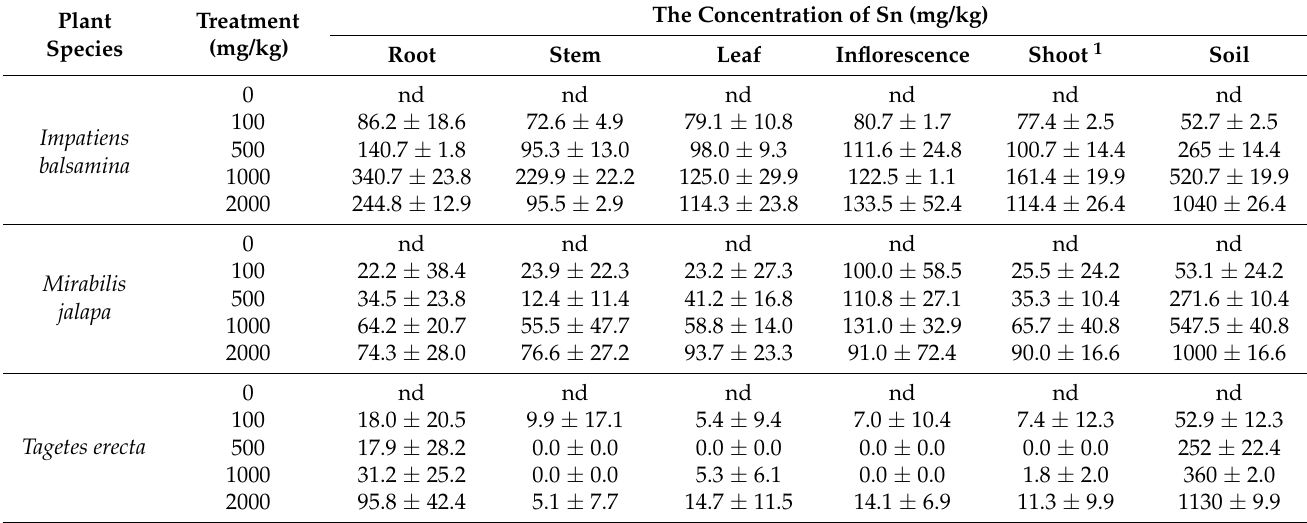
Table 1. Accumulation characteristics of plants grown in Sn-contaminated